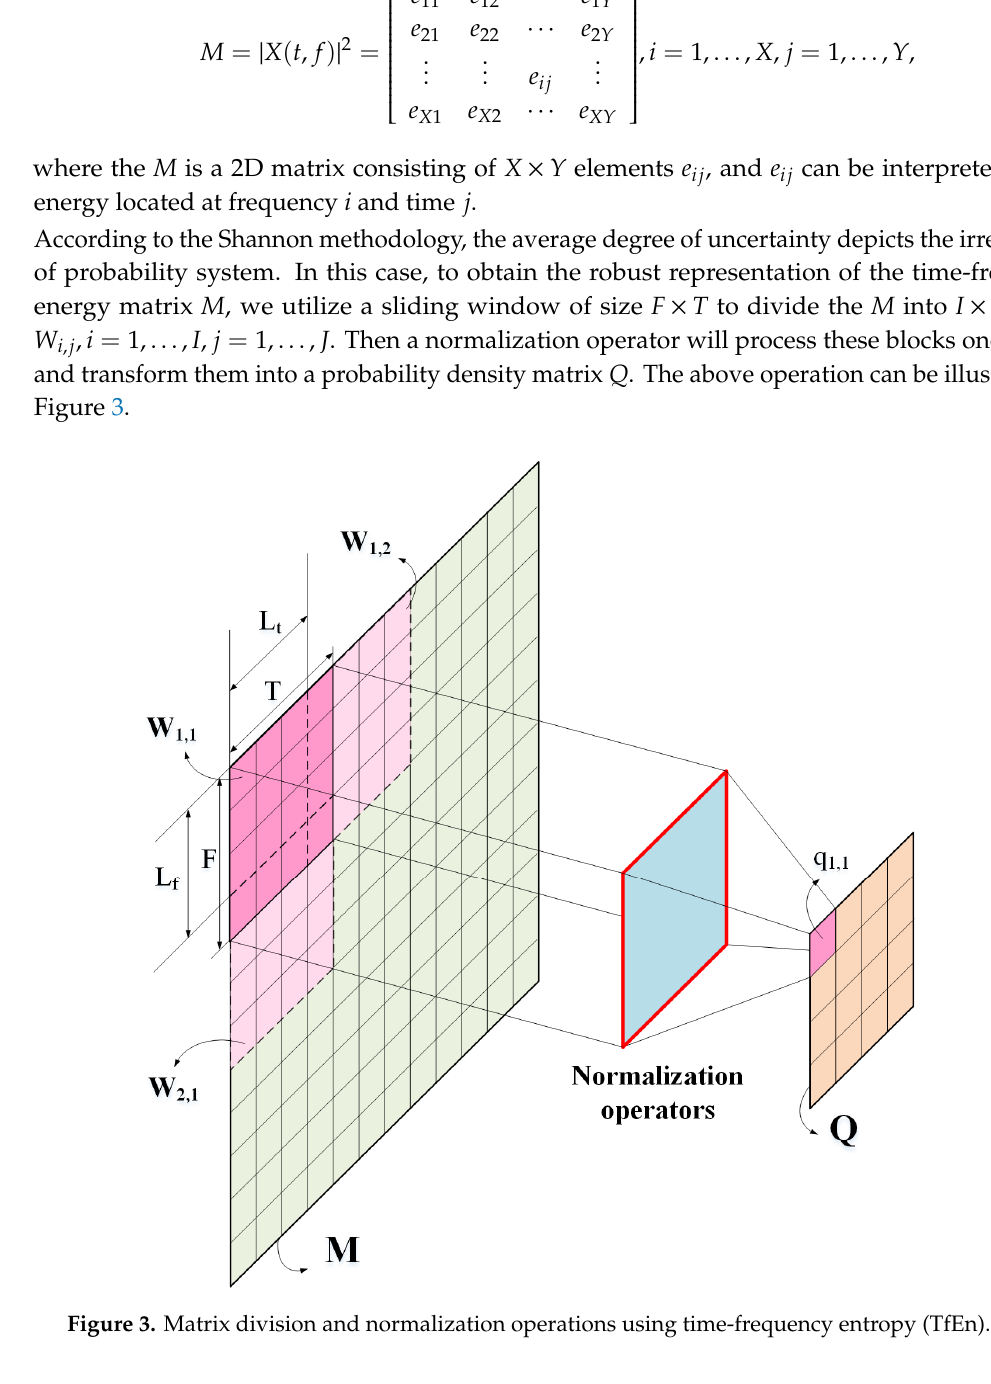
AsshowninFigure3,the F , T , L f and L t are4hyper-parametersofourproposedTfEn,whichrespectively represent the span of frequency-axis, span of time-axis, translation span of frequency-axis and translation span of time-axis of each time-frequency